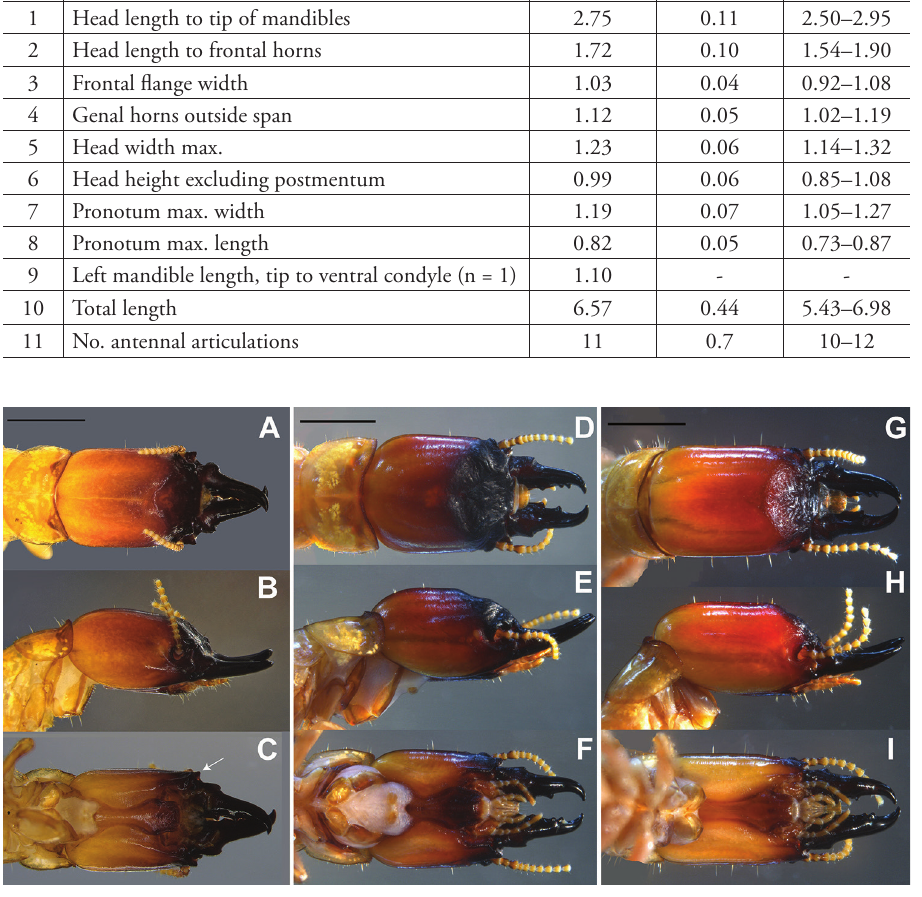
Figure 4. Soldier heads of Proneotermes macondianus sp. n. ( A–C ), Proneotermes latifrons ( D–F ), Prone- otermes perezi ( G–I ). Head in dorsal ( A, D, G ), lateral ( B, E, H ) and ventral position ( C, F, I ). Arrow in 4C denote genal horn projected prominently in Proneotermes macondianus sp. n. Scale bars: 1